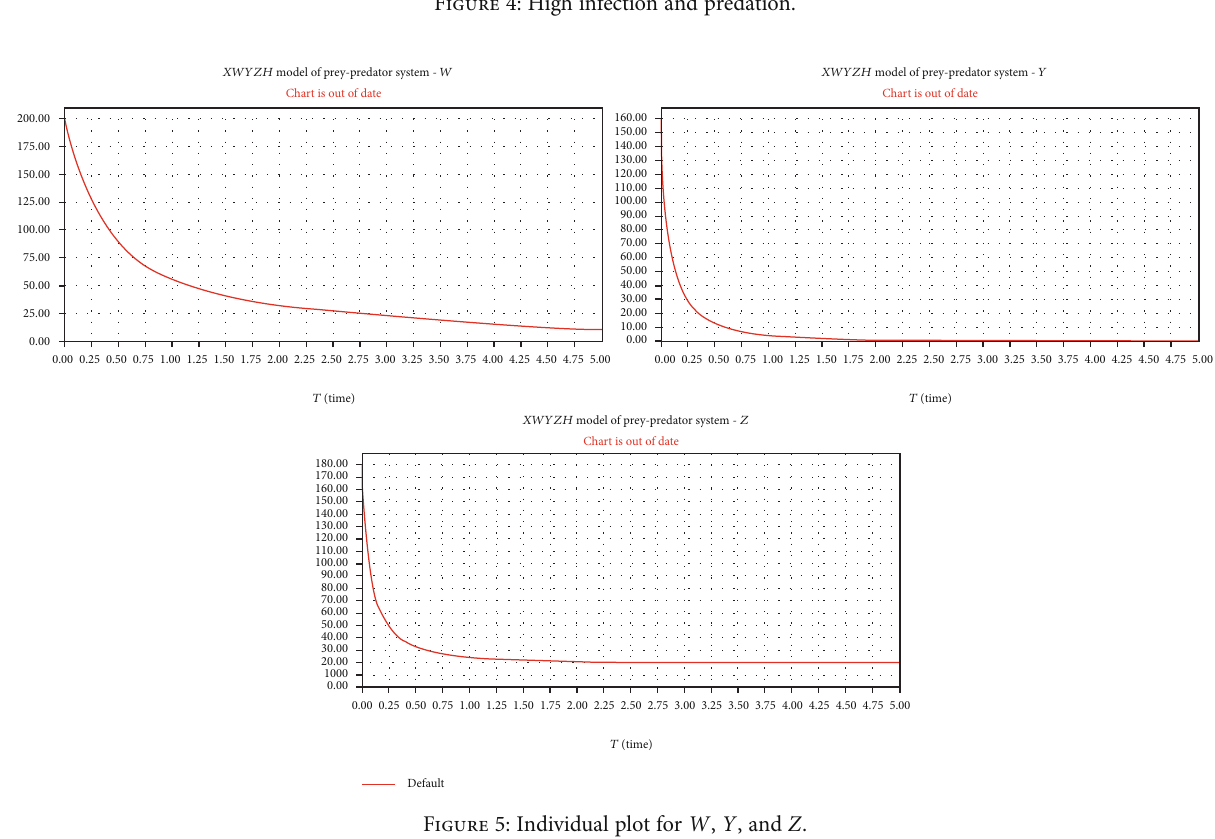
Figure 4: High infection and predation.